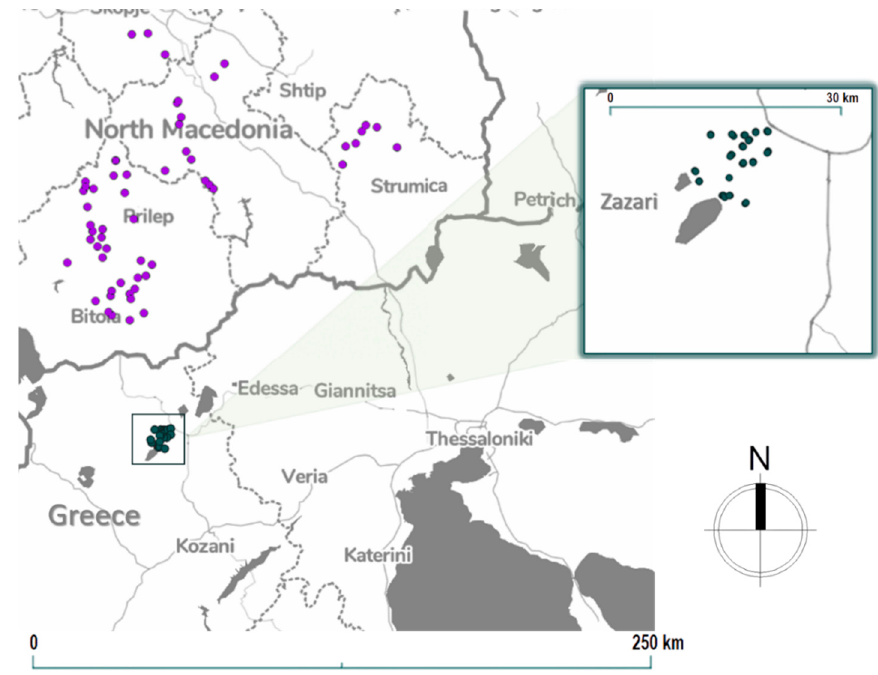
Figure 1. Spatial distribution of soil samples along the MKD and Zazari region (Greece).